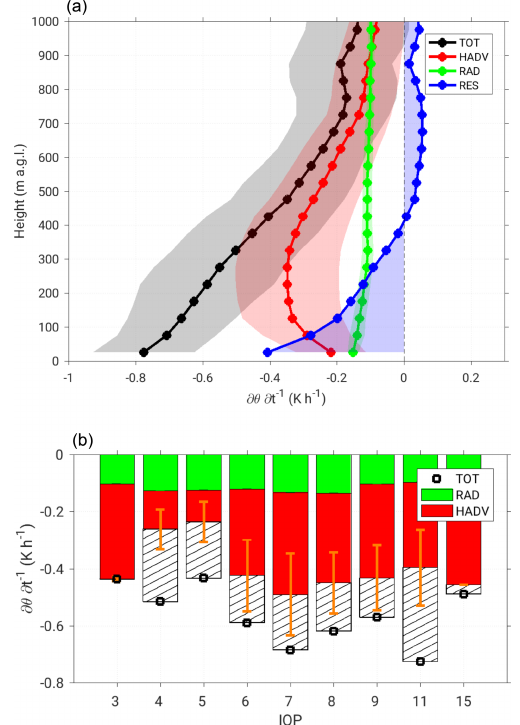
Figure 9. Mean profiles of potential temperature ten- dency (TOT), the contributions by horizontal advection (HADV) and radiative flux divergence (RAD) and the residual (RES = TOT − HADV − RAD) between 17:00UTC and the end of the jet phase (see Fig. 2) averaged for all IOPs (a) . Shading for TOT, HADV and RAD indicates the standard deviation and shading for RES marks the area between the RES and 0Kh − 1 . Vertically averaged TOT, RAD and HADV for individual IOPs (b). The values are averaged up to the height where TOT decreases below 1 /e of the maximum cooling. The hashed areas indicate the residual. The error bars for HADV result from the usage of three coastal stations and four maximum inland propagation distances of the maritime inflow to estimate HADV. Note that IOPs 1 and 14 are not considered due to missing soundings at the